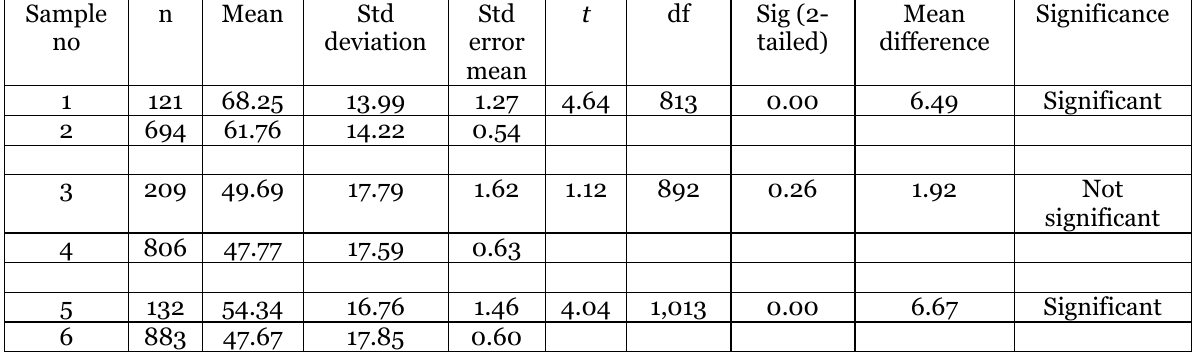
T-tests for the Three Pairs of Independent Samples